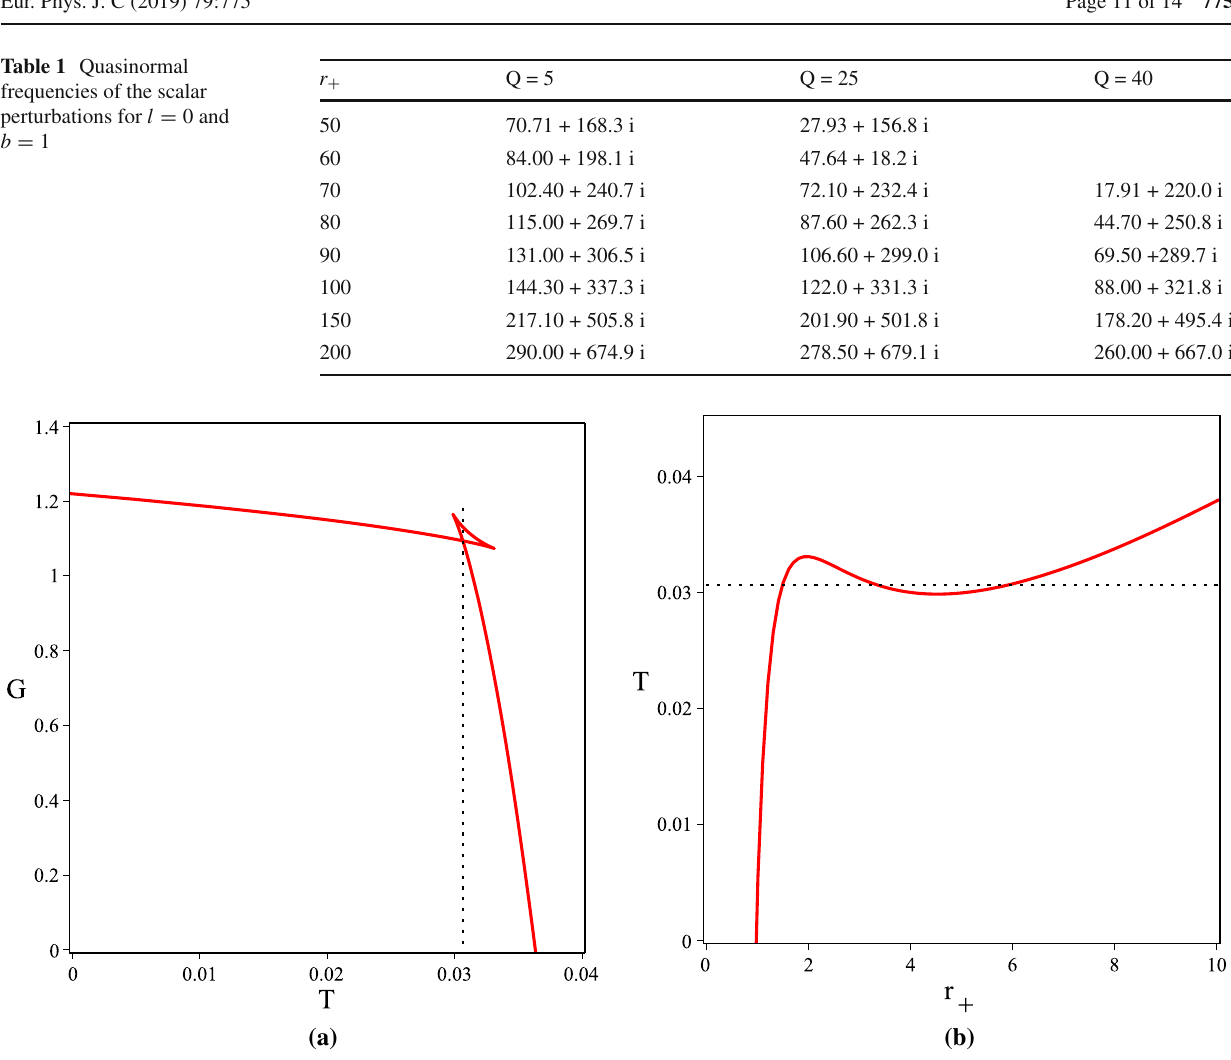
Fig. 14 The Gibbs free energy is given as a function of temperature for Q = 1 , P = 0 . 0015 and T c = 0 . 0306 (left). The behavior of black hole temperature T as a function of the black hole horizon r + for Q = 1 , P = 0 . 0015 (right)